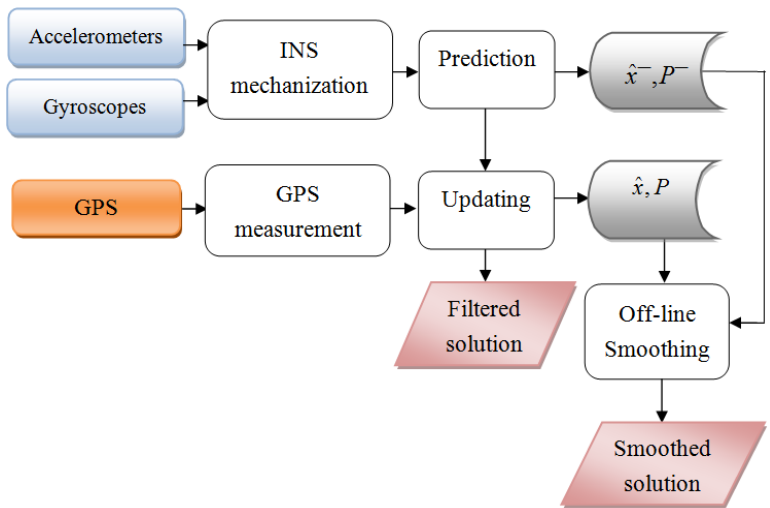
Figure 2. Integrated architecture with KF and off-line